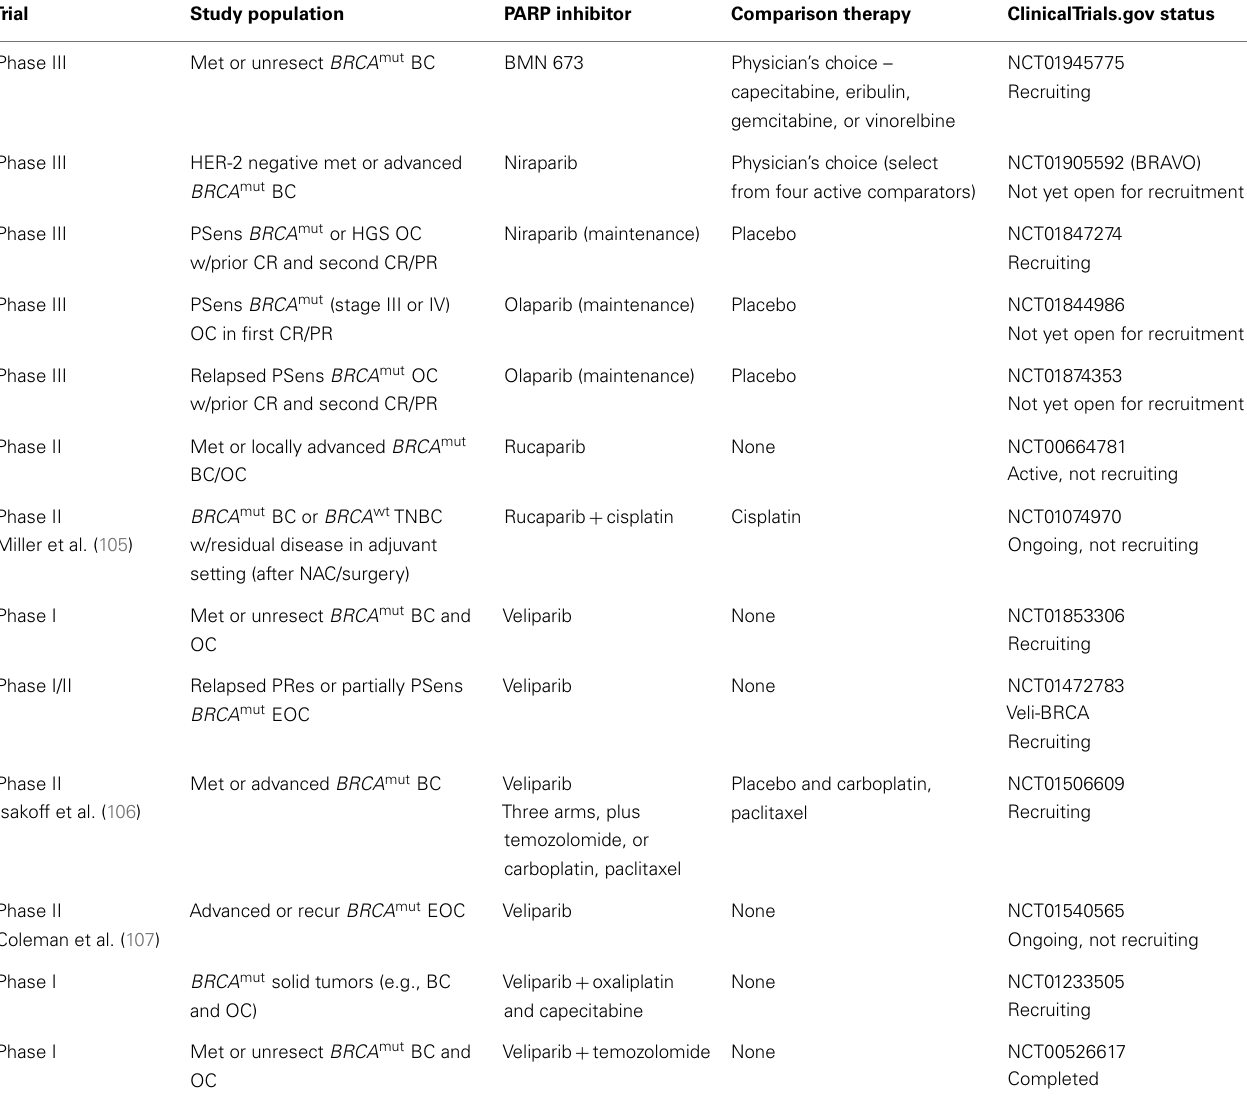
Table 5 | Ongoing or future PARP inhibitor trials in BRCA 1/2 -mutated ( BRCA mut ) breast and ovarian